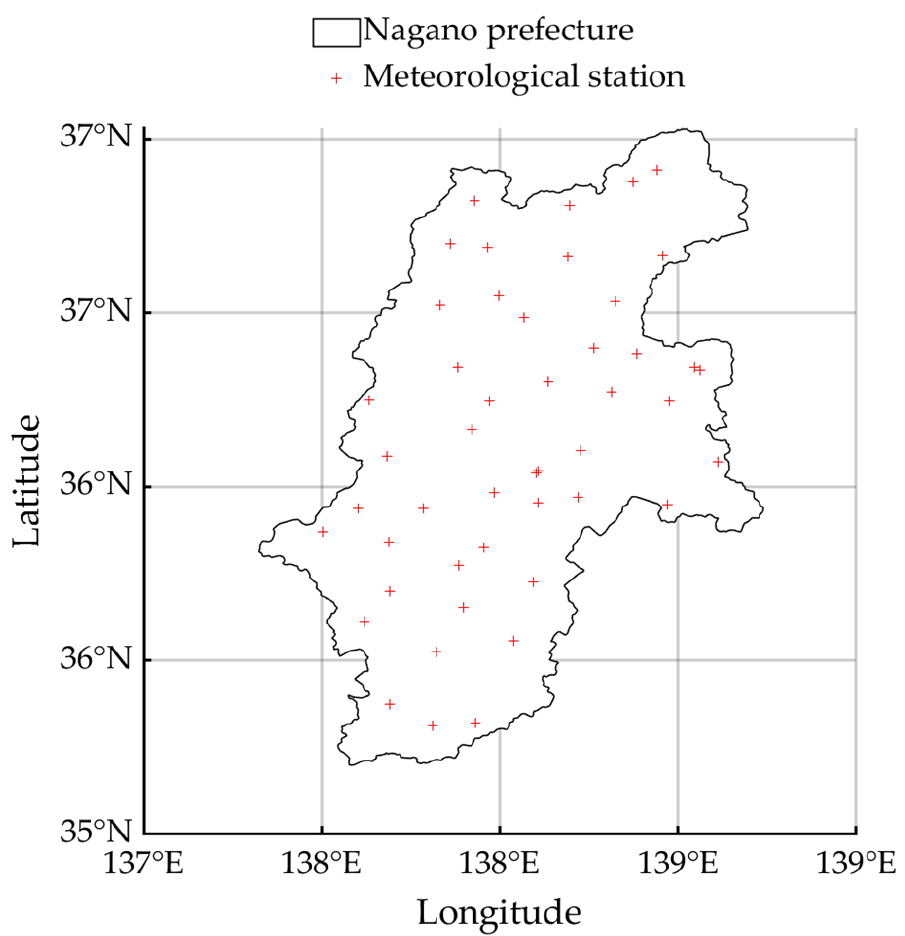
Figure 7. Distribution of meteorological stations established in Nagano Prefecture.